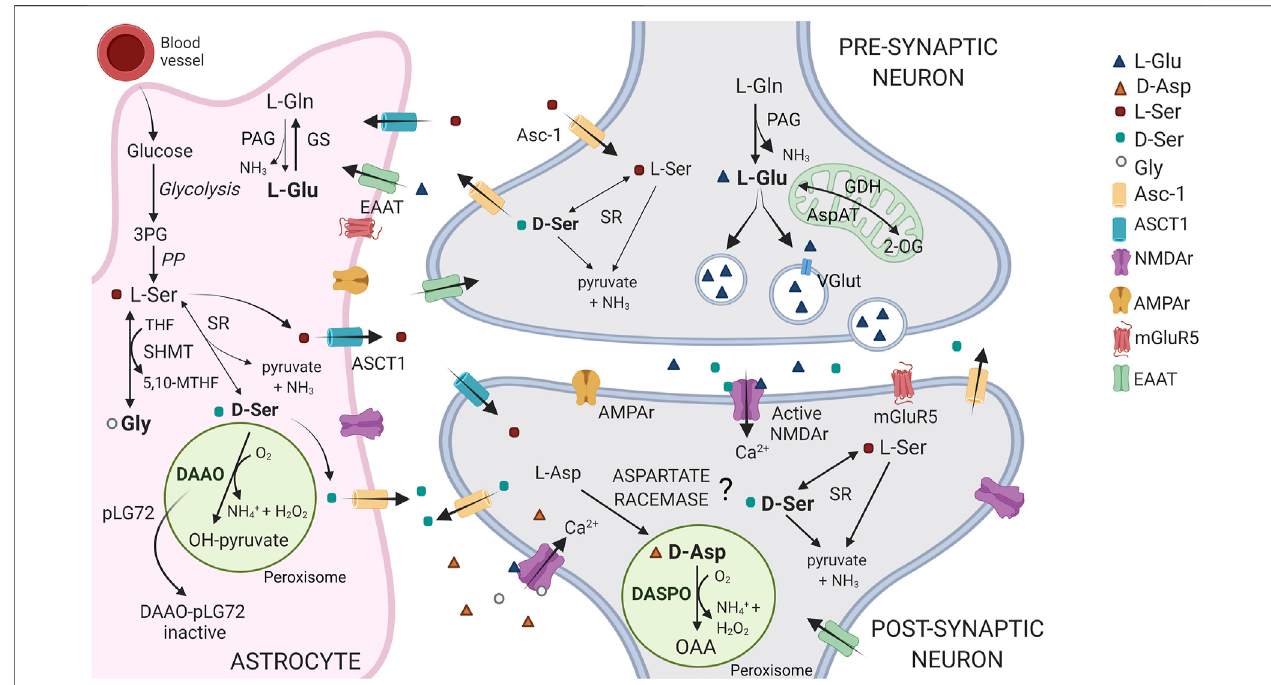
FIGURE1| SchematicrepresentationoftheD-Asp,D-SerandGlupathwaysattripartitesynapsis.Inthebrain,D-AspandDASPOareprimarilypresentinneurons, within the peroxisomes. D-Asp biosynthetic pathway is still debated: the presence of an enzyme acting as an aspartate racemase has been proposed. L-Ser is largely synthesized in astrocytes from the glycolytic intermediate 3-phosphoglycerate (3PG), through the so called “ phosphorylated pathway ” (PP). L-Ser is released from astrocytes by the alanine/serine/cysteine/threonine transporter-1 (ASCT1) and is then taken up into neurons via transporter(s), where it is converted to D-Ser by serineracemase(SR).D-Seristhenreleasedatthesynapsisbythealanine-serine-cysteine-1transporter(Asc-1,atleastinpart),whereitbindstoNMDAreceptorsatthe coagonist regulatory site. Finally, it is removed from the synaptic cleft by reuptake into astrocytes where it is catabolized by DAAO, which activity is controlled by the interaction with the regulatory protein pLG72. Notably, L-Ser is also converted into glycine (the other coagonist of the NMDA receptor) by the enzyme serine hydroxymethyltransferase (SHMT). In neurons, the principal agonist of NMDA receptors, Glu is mainly produced from the reaction catalyzed by phosphate-activated glutaminase (PAG) and uploaded in vesicles through the vesicular glutamate transporter (VGlut), for the subsequent synaptic release and post-synaptic neurons stimulation. Glu signal is terminated by the uptake into astrocytes that occurs through the amino acid transporters (EEAT). In glial cells, Glu is converted to Gln via glutamine synthetase (GS) or 2-oxoglutarate by glutamate dehydrogenase or aspartate aminotransferase (GDH and AspAT) for subsequent oxidative metabolism in the Krebs cycle. Gln is then shuttled back to neurons. 2-OG (cid:1) 2-oxoglutarate; OAA (cid:1) oxaloacetate.